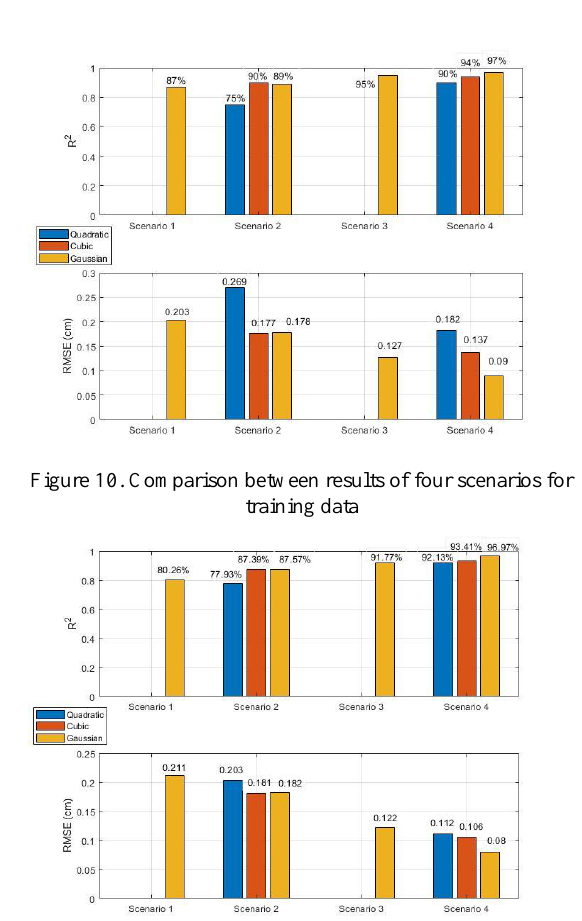
Figure 11. Comparison between results of four scenarios for testing